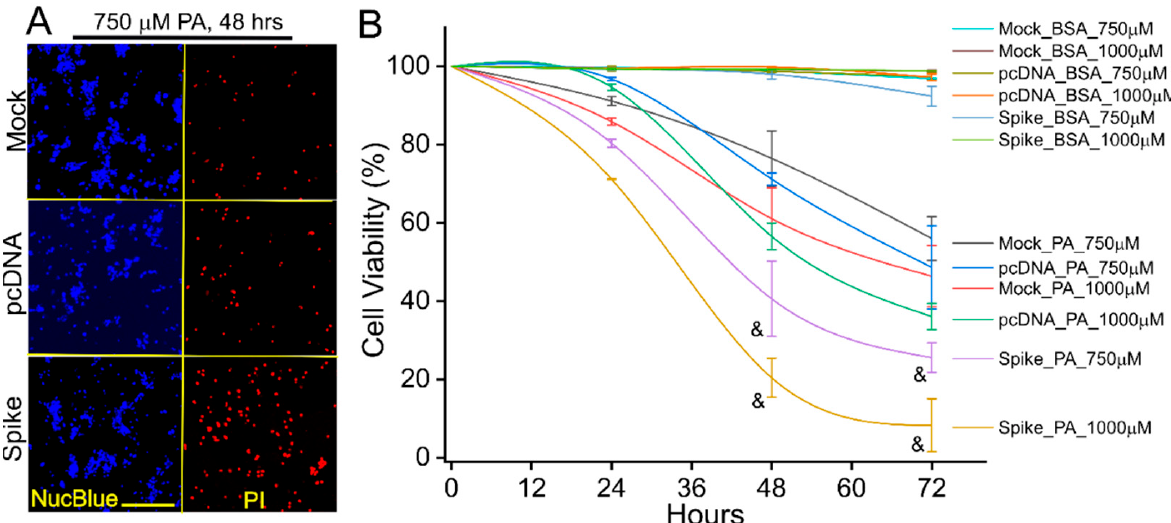
Figure 3. The Spike protein-exaggerated PA-induced lipotoxicity in host cells. ( A ) Fluorescent images showing the cell viability in the mock, pcDNA, and Spike cells treated by 750 µM PA for 48 h in DMEM containing 5% FBS. The cells were co-stained by Propidium Iodide (PI) and Hoechst 33342 NucBlue Live Cell Stain dye to show the dead and live cells, respectively. Scale bar, 25 µm. ( B ) Cell viability curves of mock, pcDNA, and Spike cells in response to PA (750 or 1000 µM) treatments for 24 to 72 h. & indicates p < 0.05 in the Spike cells as compared with the mock and pcDNA control cells in response to the same dosages of PA at 48 or 72 h. n = 5~6 wells in each dose and time point.